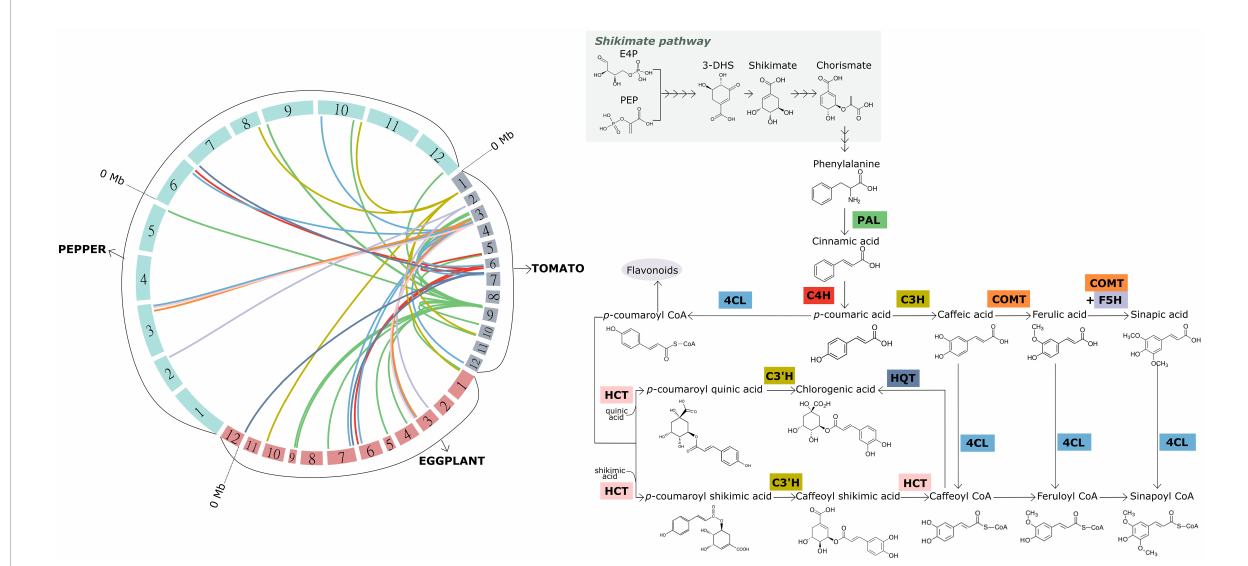
FIGURE 2 Macrosynteny among the tomato, eggplant and pepper genomes for candidate genes encoding the key enzymes involved in the synthesis of hydroxycinnamic acids (left), and overview of the aforementioned synthesis pathway (right). The 12 chromosomes of each of the three genomes represented, which are arranged to form the circle on the left, are colored differently according to the species. The chromosomes are scaled according to their size (Mb). Links with different colors inside the circle were used to connect the physical position of homologous genes within and among the genomes. Same color links represent genes encoding the same key enzyme of the pathway. The acronym of each key enzyme is indicated along the synthesis pathway (right), and framed in the same color as the corresponding link. PAL, phenylalanine ammonia-lyase; C4H, cinnamate 4-hydroxylase; 4CL, 4-coumaroyl-CoA ligase; C3H, 4-coumarate 3-hydroxylase; C3 ’ H, p-coumaroyl ester 3 ′ -hydroxylase; HCT, hydroxycinnamoyl-CoA:shikimate/quinate hydroxycinnamoyl transferase; HQT, hydroxycinnamoyl-CoA:quinate hydroxycinnamoyl transferase; COMT, caffeate O-methyltransferase; F5H, ferulate 5-hydroxylase (F5H). The genes used for creating the links resulted from a blastp against the current protein databases of tomato, eggplant and pepper at the Sol Genomics platform (http://www.solgenomics.net). The hits with the lowest e- value, higher sequence size and higher sequence identity (>70%) were